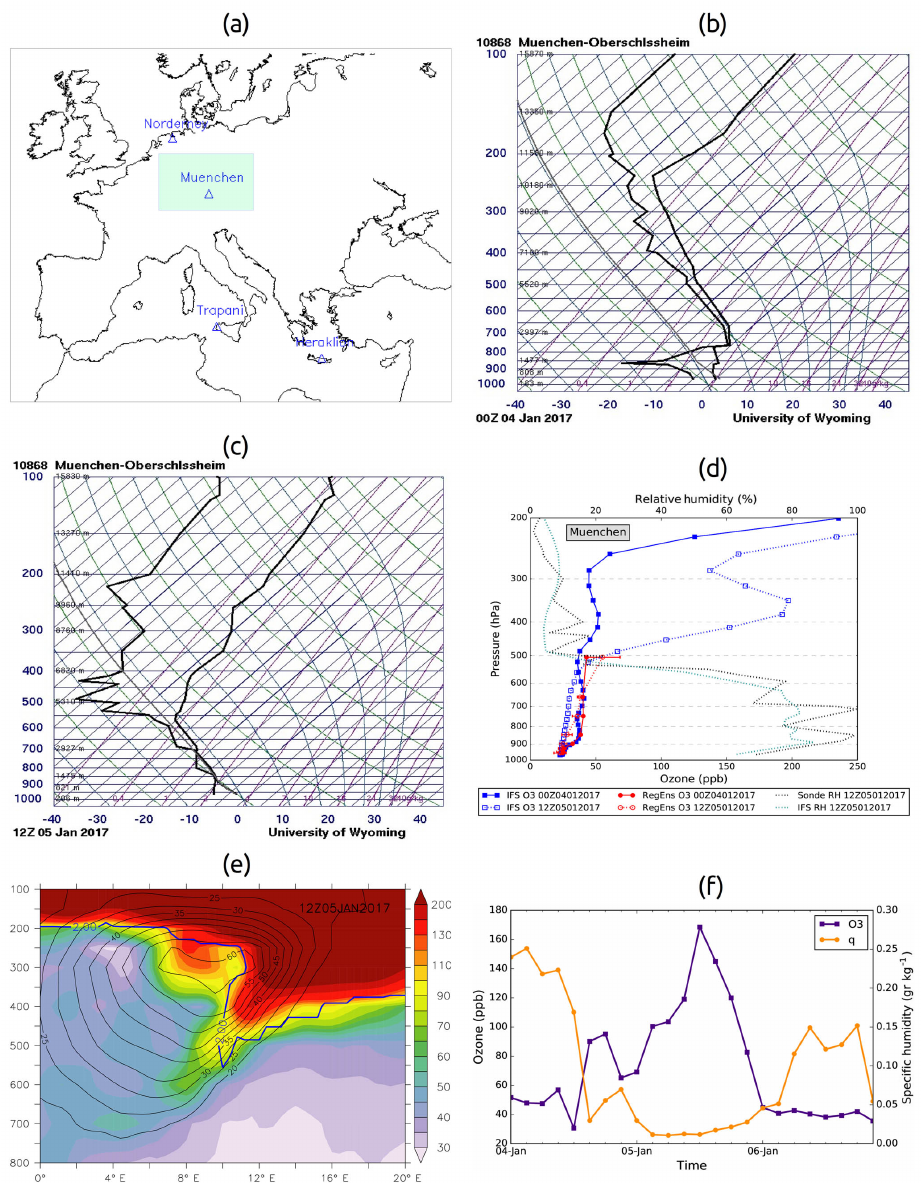
Figure 6. (a) Muenchen, Germany location. (b) Skew-T log-P diagrams at 00:00Z on 4 January 2017 and (c) 12:00Z on 5 January 2017. (d) Vertical profiles of IFS (blue) and RegEns (red) ozone mixing ratio (ppb) at 00:00Z on 4 January 2017 (solid line) and 12:00Z on 5 January 2017 (dashed line). The red bars denote the standard deviation among the regional ensemble members. Also shown are sonde (dashed black line) and IFS relative humidity (dashed cyan line) at 12:00Z on 5 January 2017. (e) Longitude–pressure vertical cross section at 48.4 ◦ N of IFS ozone mixing ratio (in ppb; colour shaded), wind speed (in ms − 1 ; black contours) and PV (2pvu; blue contours) at 12:00Z on 5 January 2017. (f) IFS ozone (blue) and specific humidity (orange) time series at